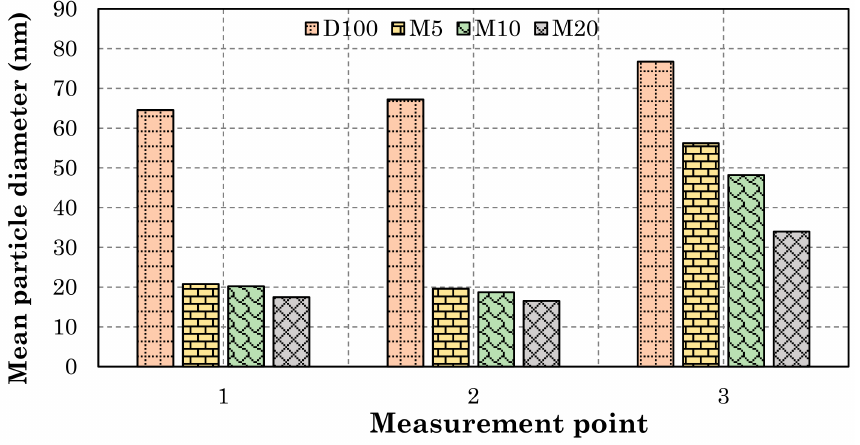
Figure 18. Mean diameter of soot particles in size range 5.6–560 nm for all test fuels at all measurement